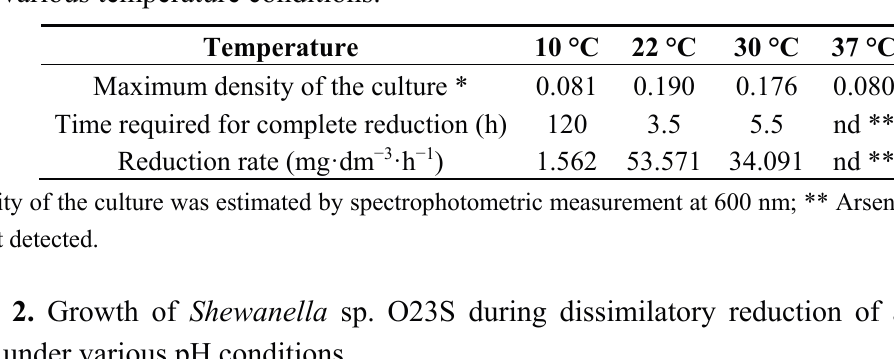
Table 1. Growth of Shewanella sp. O23S during dissimilatory reduction of arsenate at pH 8 under various temperature conditions.